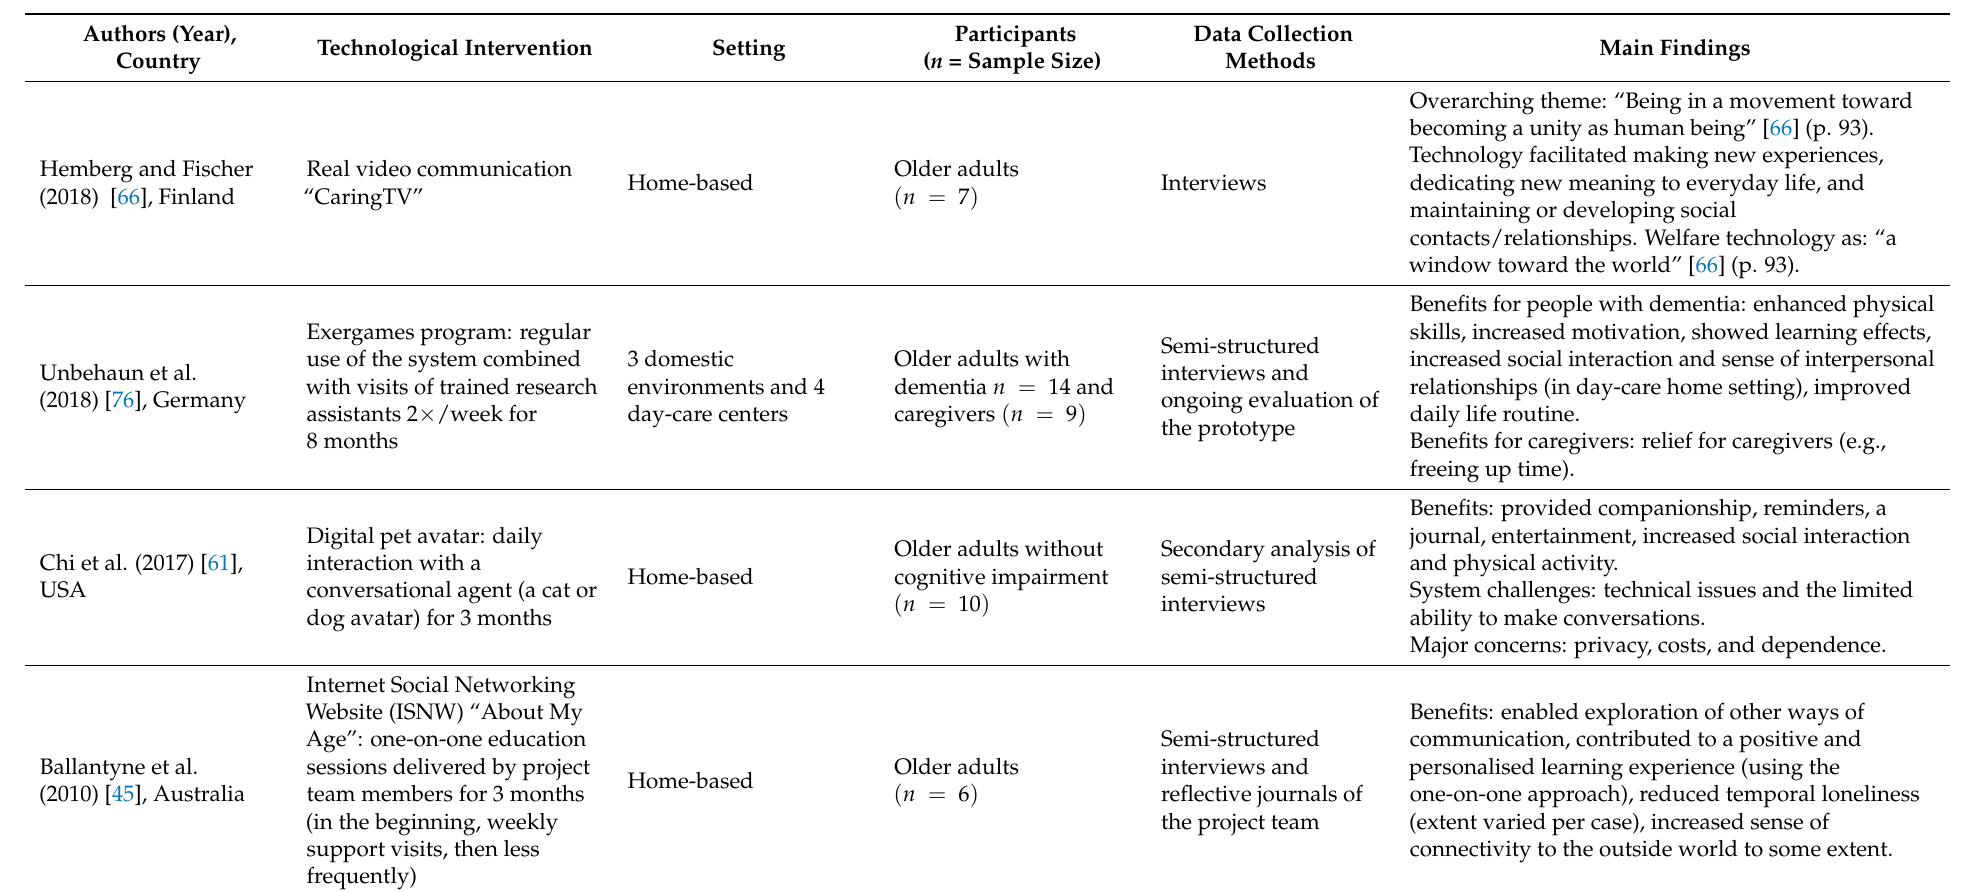
Table 6. Methods and main findings reported from included qualitative